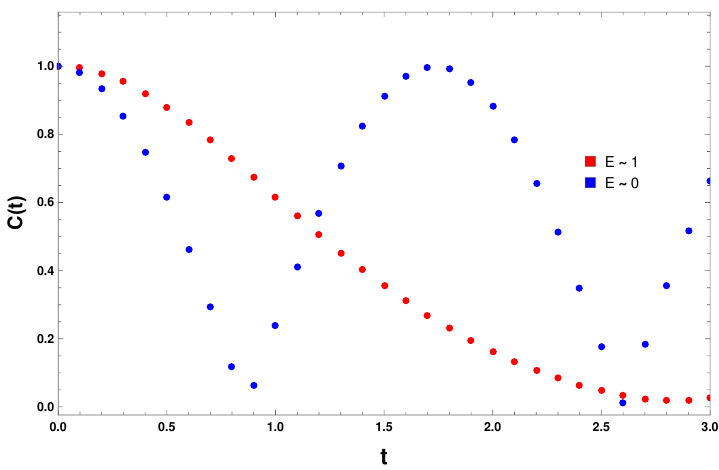
Figure 7. The behavior of the microcanonical auto-correlation function C ( t ) with t for different values of energy E . The function C ( t ) decays rapidly for E ∼ 1 and shows oscillatory for E ∼ 0 . This behavior is consistent with the fact that the even and odd Lanczos coefficients behave differently away from the saddle. In contrast, their growth is very similar at the saddle and nearly